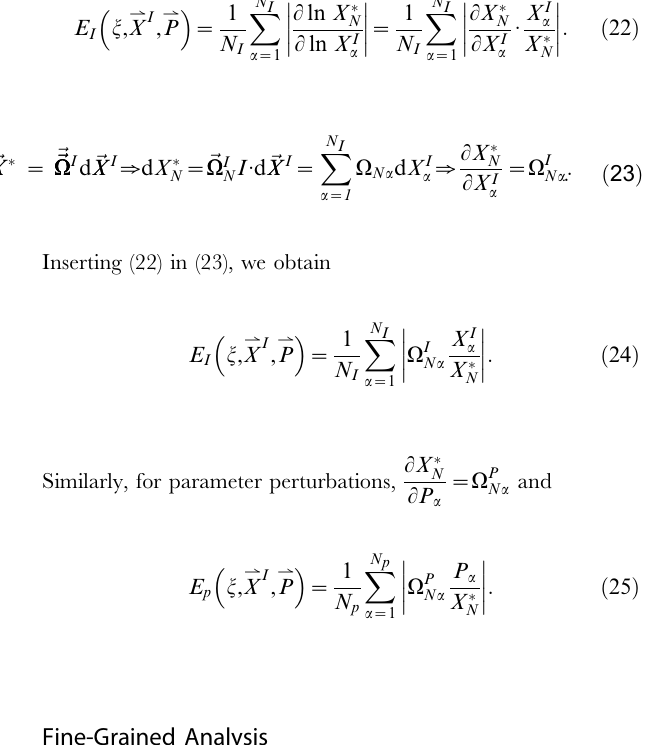
from the average over TR networks (blue) or from the average over NP networks (green). The linear regression for all sizes (3- node, 5-node, 10-node, 15-node, and 30-node) shows a significant node topologies: Within TR networks, slope= 0.50 (red line: N =4213, r=0.75). Within NP networks, slope =0.48 (black line: N =4213, r= 0.60). (B) 5-node topologies: Within TR networks, slope =0.50 (red line: N = 15756, r= 0.56). Within NP networks, slope =0.39 (black line: N = 15756, r= 0.48). (C)